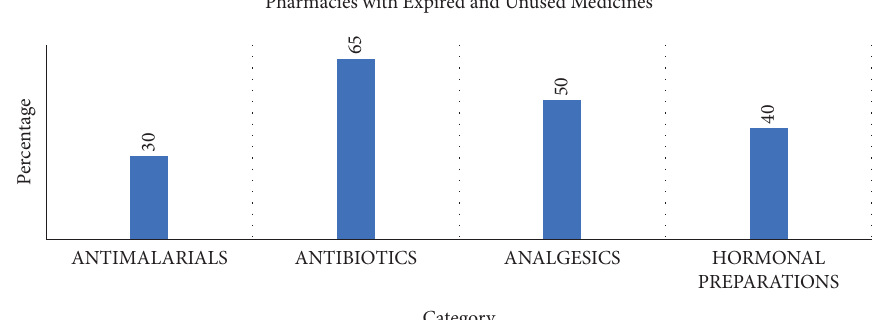
Figure 5: Te percentage of pharmacies holding medicines requiring disposal in the Krowor municipality. Data represent the means for each group ( n � 35).